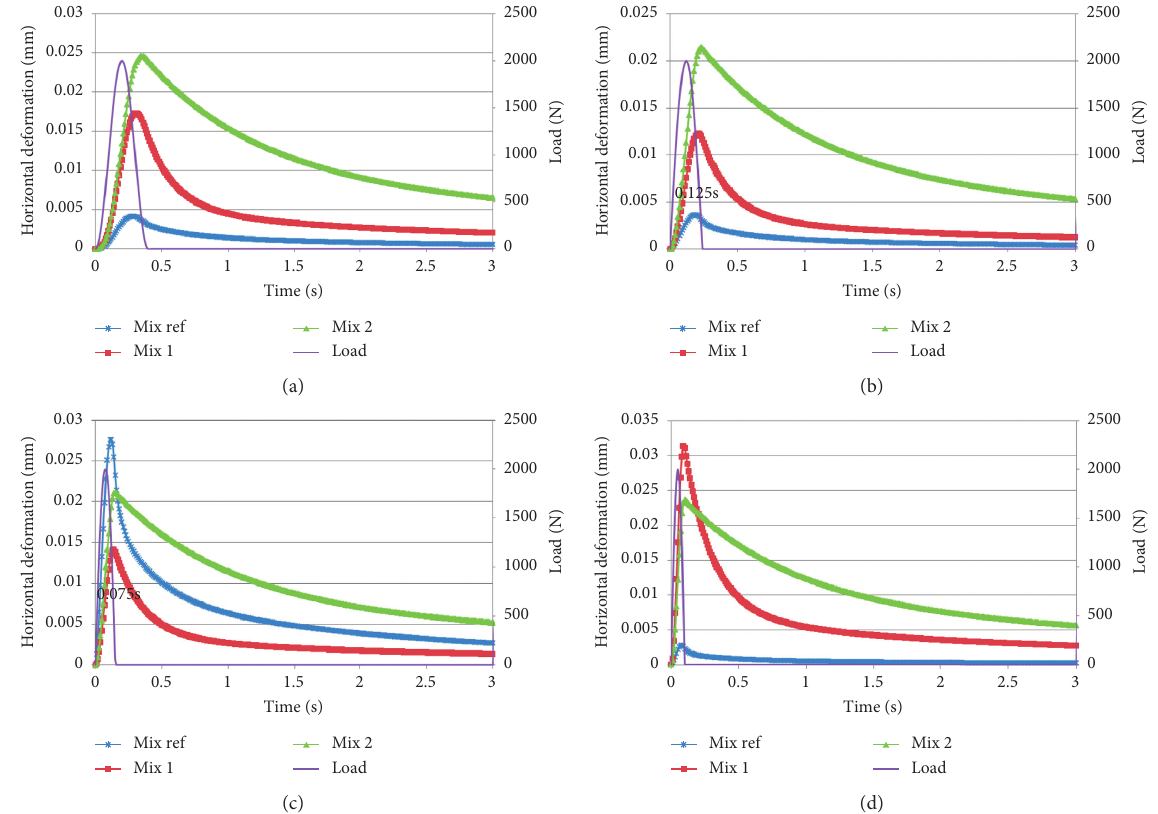
Figure 7: Simulation results: (a) f � 1.1Hz; (b) f � 1.8Hz; (c) f � 3.3Hz; (d) f � 5Hz in one